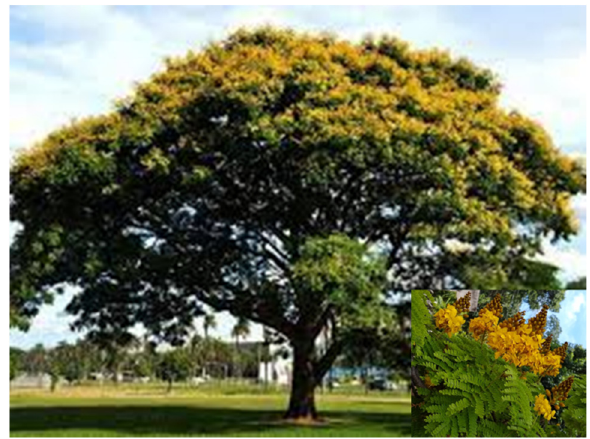
Figure 2. Example of a Sibipiruna tree with flower detail. Source: Adapted from http://www.jardimcor.com/catalogo-de-especies/cenostigma-pluviosum/, accessed on 10 January 2022.